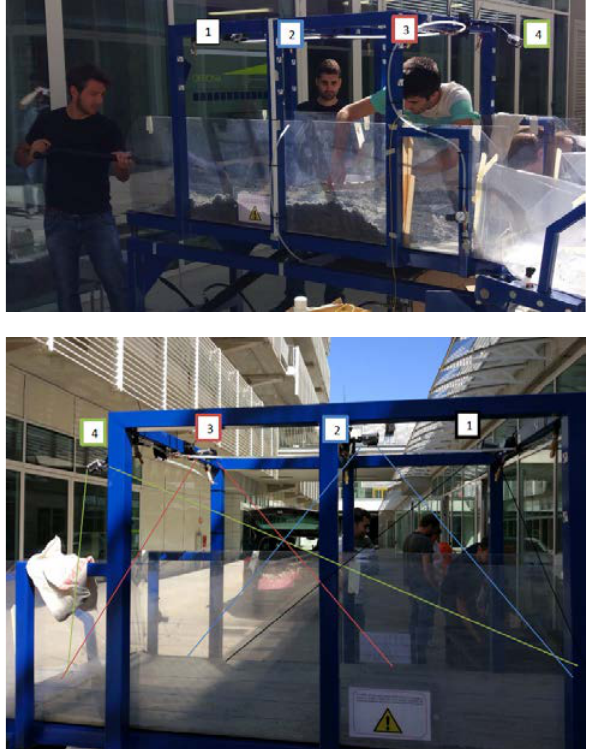
Figure 2. Locations of four GoPro 4 Black ® cameras on the landslide simulator. The bottom figure also shows the field of view of each camera.